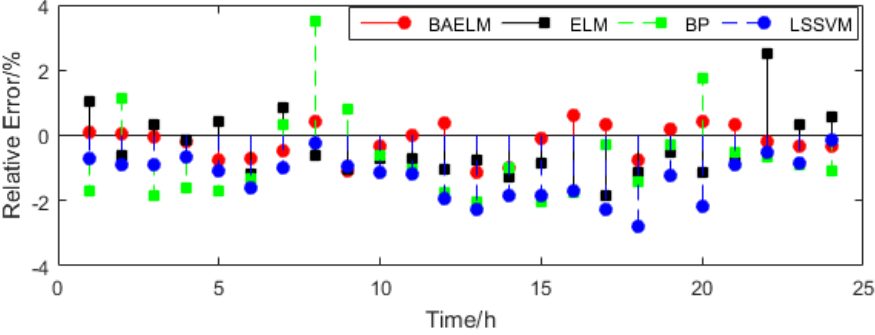
Figure 12. Compared relative errors of four models on 29 June.